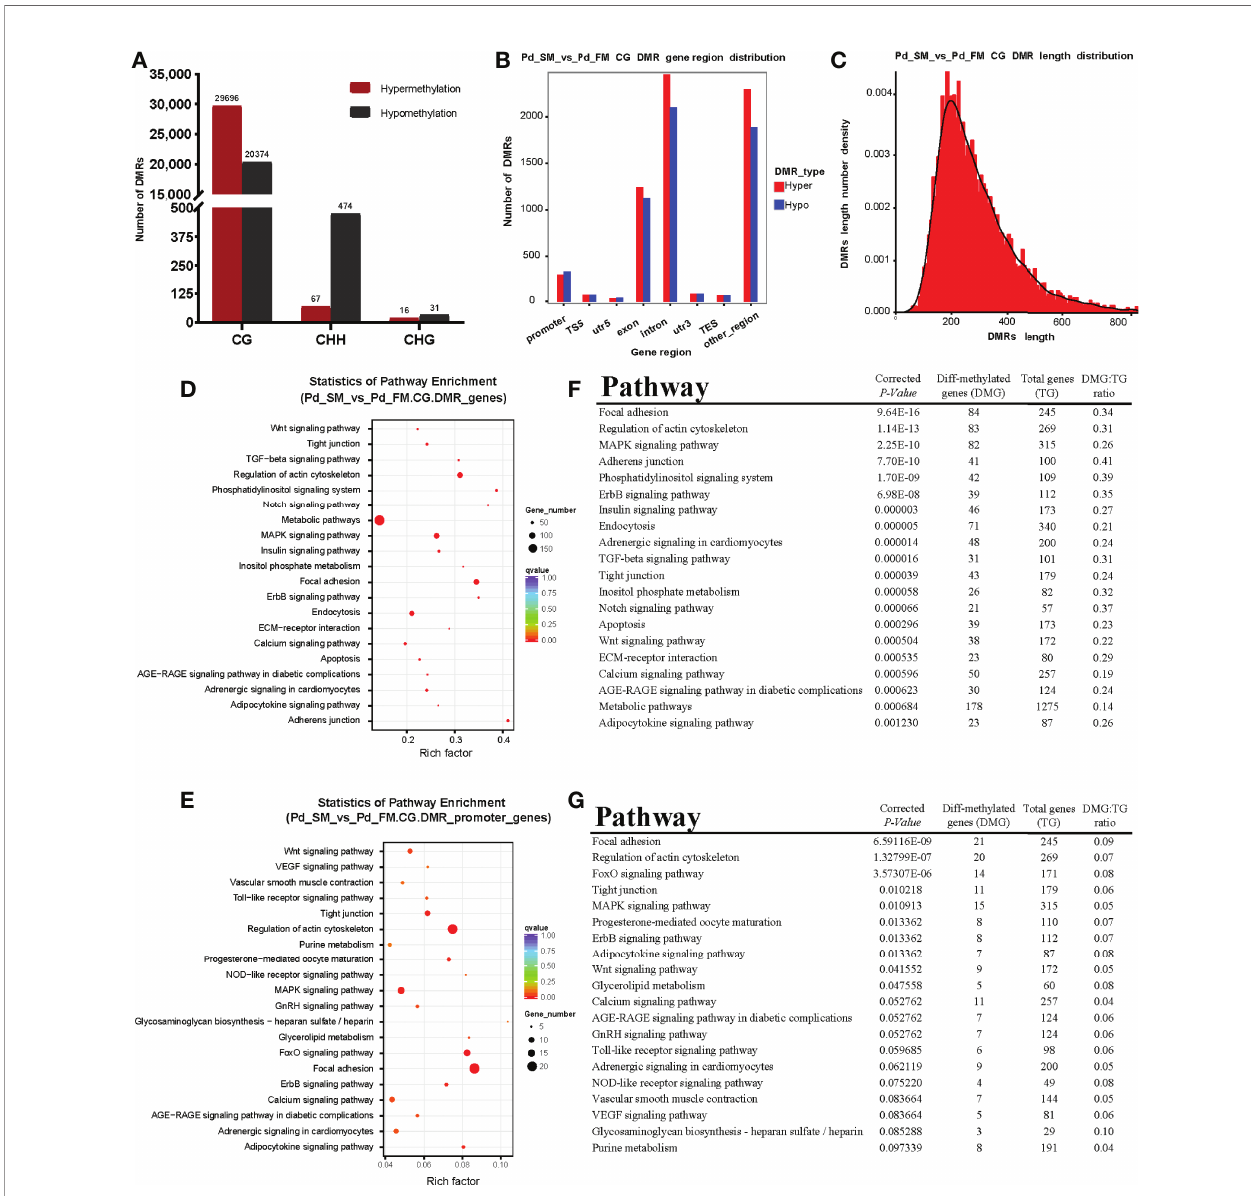
FIGURE 2 | The characteristics of DMRs and function analysis of DMGs. (A) The number of differentially methylated regions among different methylation types. (B) The distribution numbers of hyper/hypo DMRs in different genomic elements. (C) DMR length distribution density of mCGs contexts. (D, E) Scatterplot of Kyoto Encyclopedia of Genes and Genomes (KEGG) pathways enriched by the DMGs in gene body (D) and promoter region (E) between slow- and fast-twitch muscles. The vertical axis represents the name of the pathway, and the horizontal axis shows the enrichment factor. The size of the plot denotes the number of DMGs, and the color corresponds to the Qvalue. A deeper color represents a smaller Qvalue and indicates more signi fi cant enrichment of the pathway. (F, G) The top 20 pathways enriched by DMGs in gene body (F) and promoter region (G) between slow- and fast-twitch